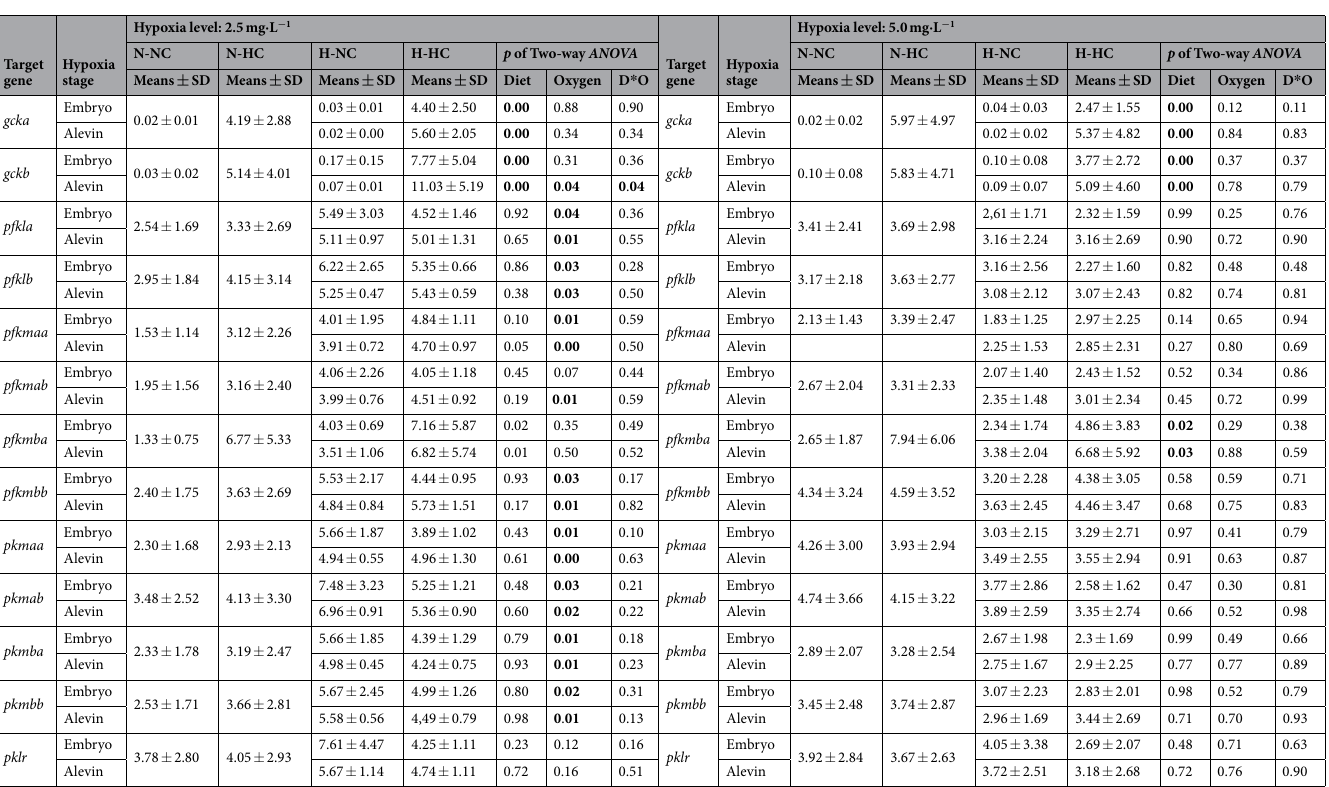
Table 3. Effects of early hypoxia and high-carbohydrate diet at first-feeding on gene expressions involved in glycolysis pathway. N-NC, N-HC, H-NC and H-HC stands for fish subjected to normoxia and no carbohydrate diet, normoxia and high carbohydrate diet, hypoxia and no carbohydrate diet and hypoxia and high carbohydrate diet, respectively. Data were presented as mean ± SD (n = 6), statistical differences were evaluated by two-way ANOVA ( p < 0.05, values in